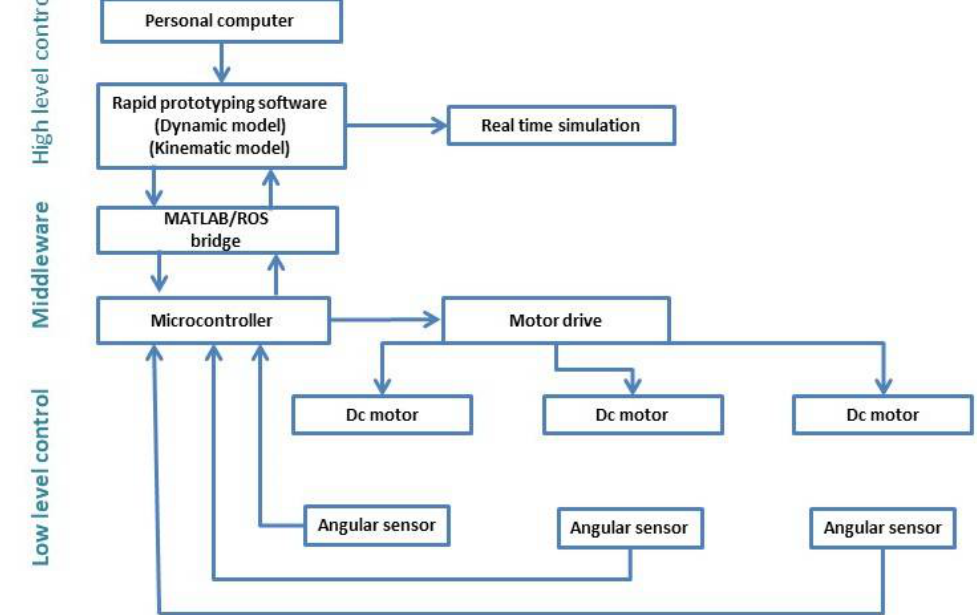
Figure 16. Control architecture of the upper limb exoskeleton SAMA.